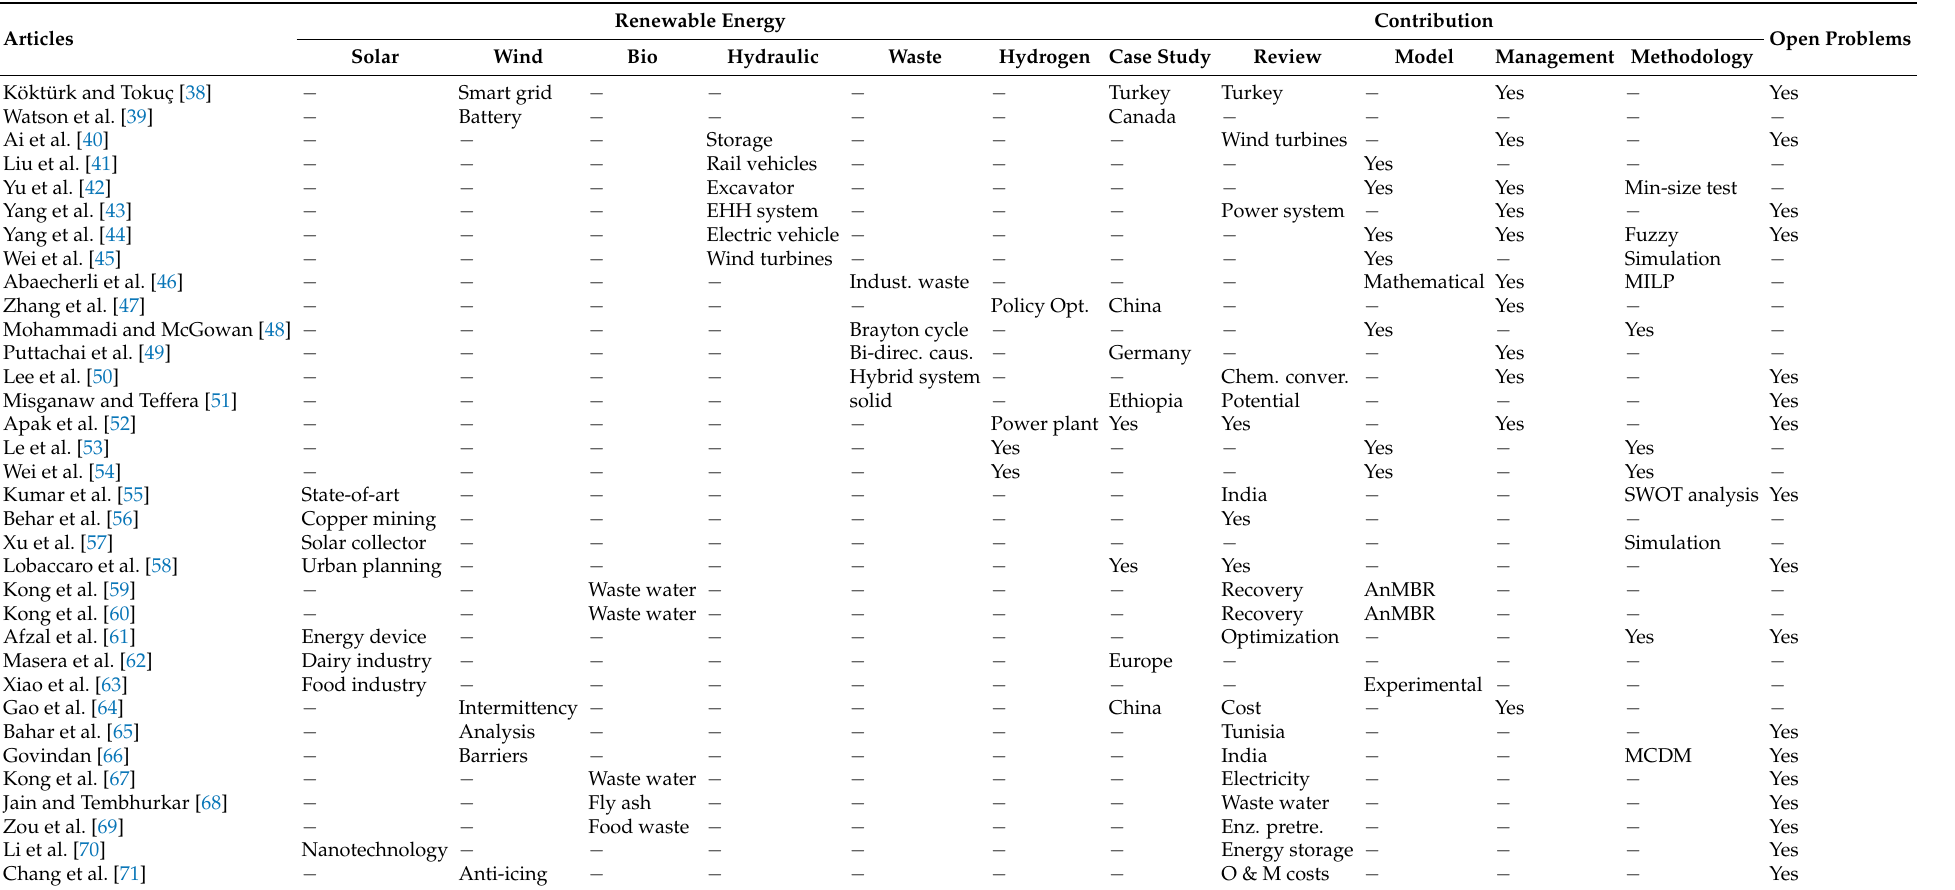
Table 1. Contribution of different